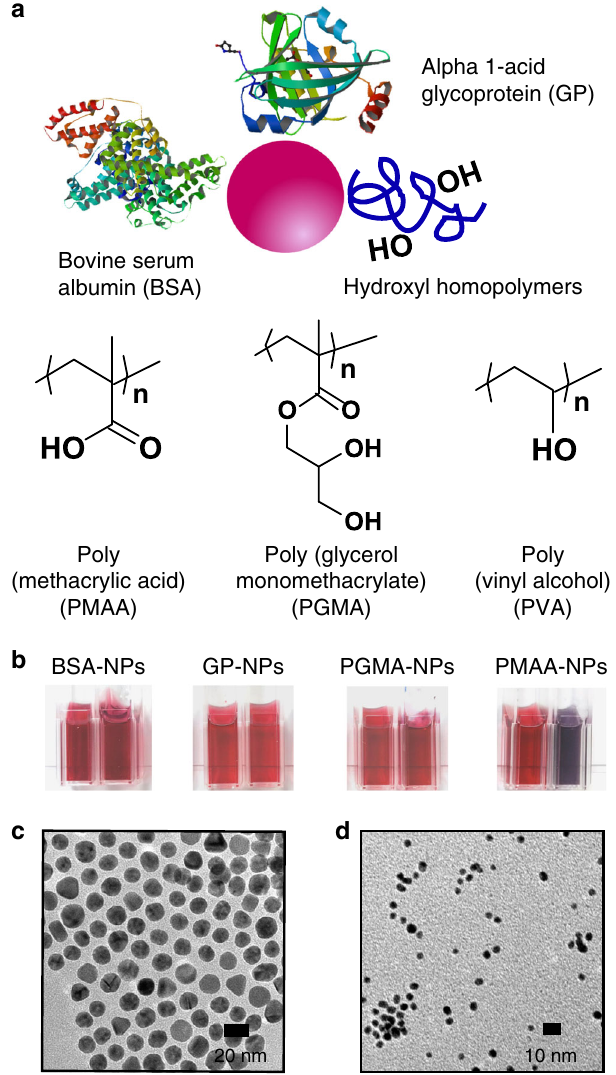
Fig. 1 Characterisation of functionalised gold nanoparticles. a Schematic diagram and chemical structures summarising the different macromolecules used in the study. Protein structures of alpha-1-acid glycoprotein (GP) and BSA are PDB(3KQ0) and PDB(3V03), respectively. b Photographs of solutions of functionalised nanoparticles in the presence of [Ca 2 + ] = 0 mM (left) and [Ca 2 + ] = 20mM, pH 9 (right). TEM images of c 14nm and d 4 nm diameter gold nanoparticles coated with